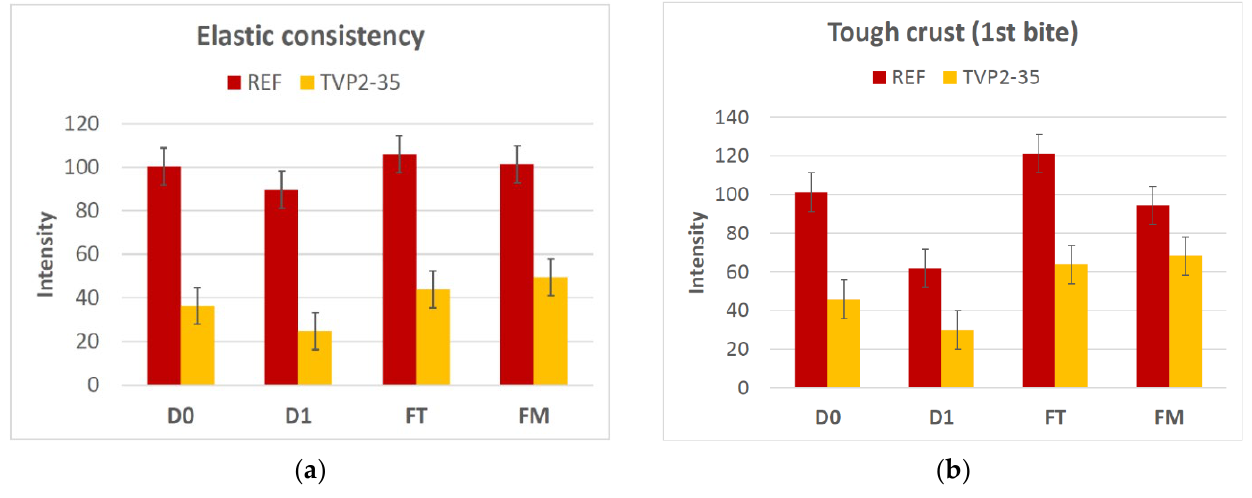
Figure 4. The intensity of the relevant sensory properties ( a ) elastic consistency and ( b ) tough crust at 1st bite in relation to robustness of the buns. The standard error (SE) for the two repetitions is shown in the figures. The reference bun (REF) contains 0% extrudate, and TVP2 contains 35% extrudate made from 49% faba bean, 40% pea, 10% quinoa, 1% salt. D0: freshly baked, D1: one day old, FT: frozen and thawed at room temperature, FM: frozen and thawed in a microwave